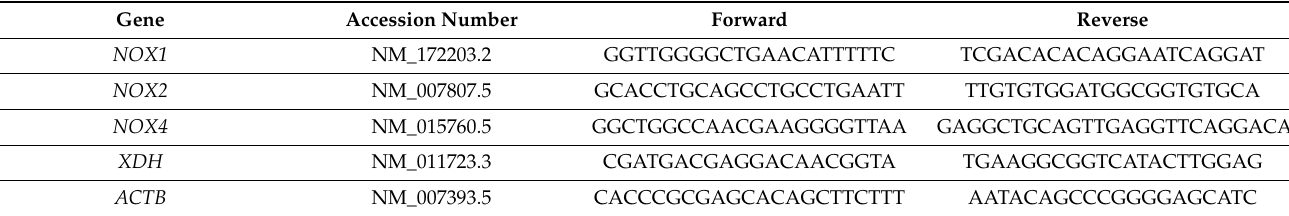
Table 1. Primer sequences used for quantitative PCR analysis in ophthalmic